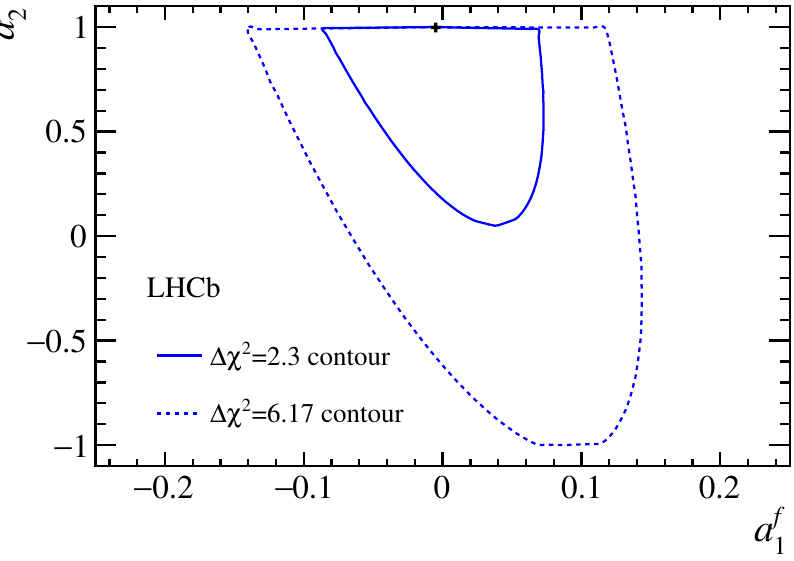
Figure 8 . ∆ χ 2 contours for the scaled parameters a f central value. The solid (dashed) contour encloses the ∆ χ 2 = 2.3 (6.17) region. The observed shape is due to the applied unitarity condition, see eq.